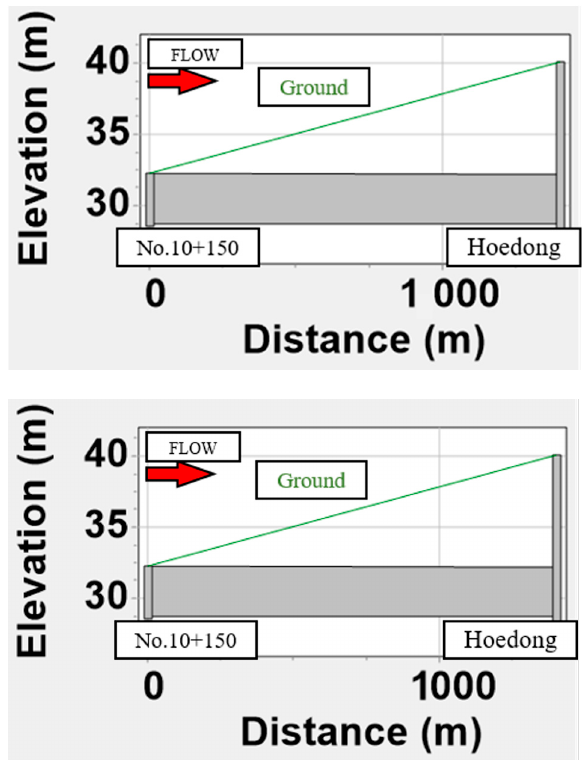
Figure 5. Longitudinal section of the underground waterway.